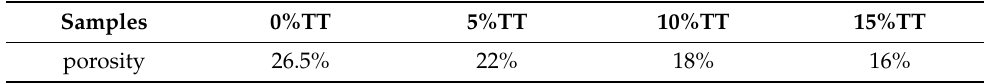
Table 3. Degree of porosity as a function of reinforcement